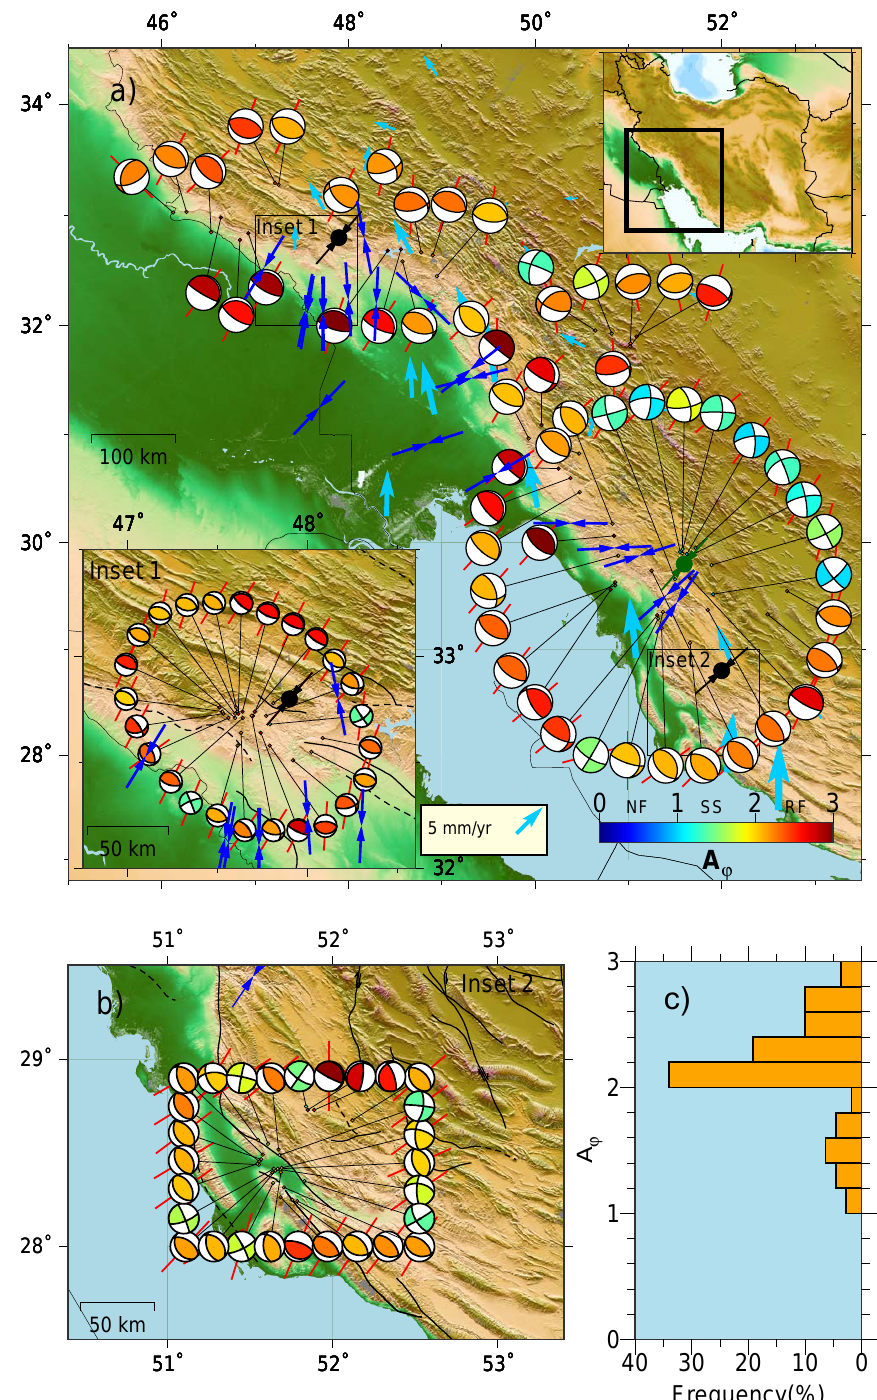
Figure 6. ( a ) Map view of the value of 108 interpreted focal mechanisms in the Dezful